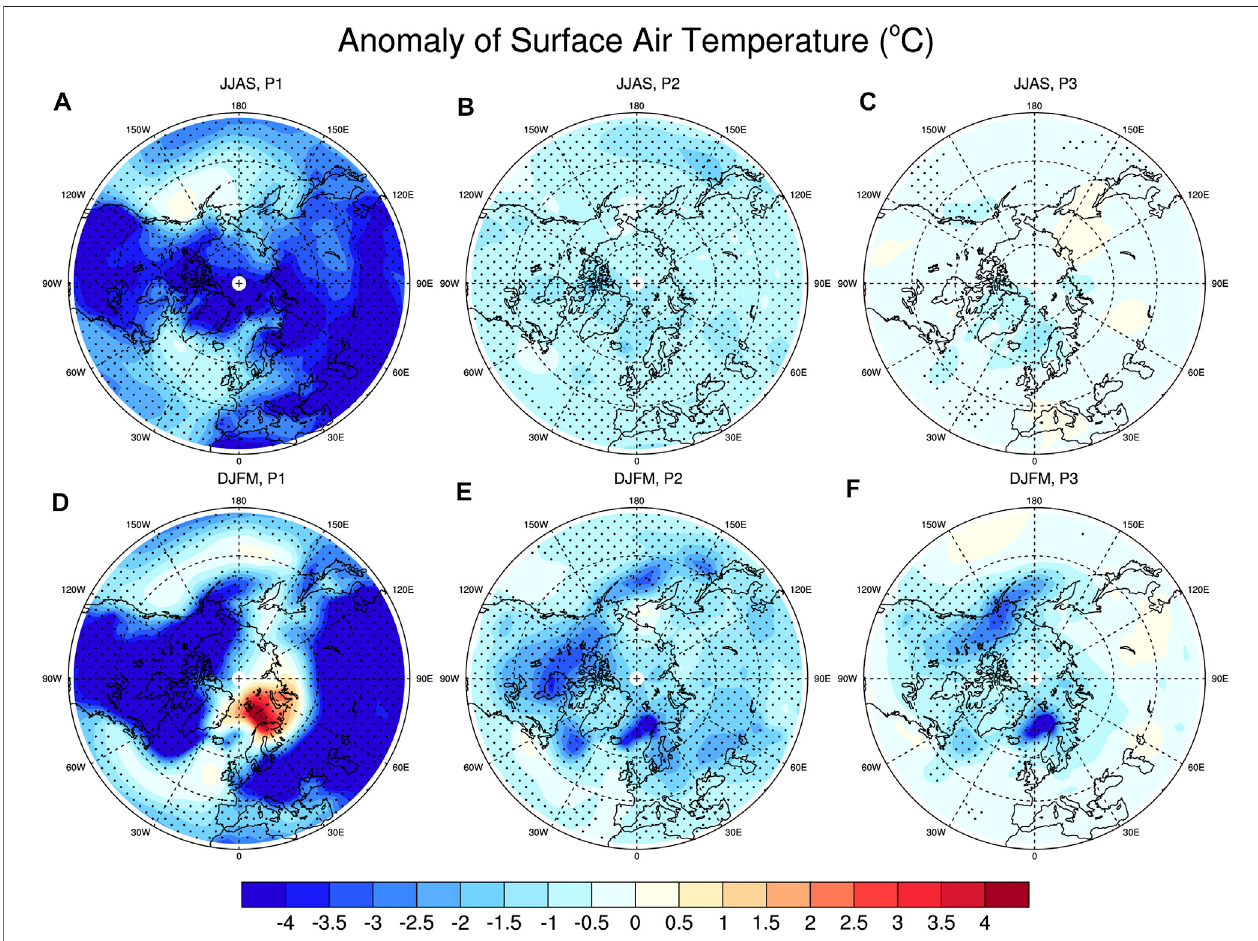
FIGURE 5 | Ensemble-mean simulated Arctic surface air temperature (SAT) anomalies in summer (JJAS, top panels) and winter (DJFM, bottom panels) during Period-1 (A,D) , Period-2 (B,E) , and Period-3 (C,F) . The dots denote areas with con fi dence exceeding the 90% level.